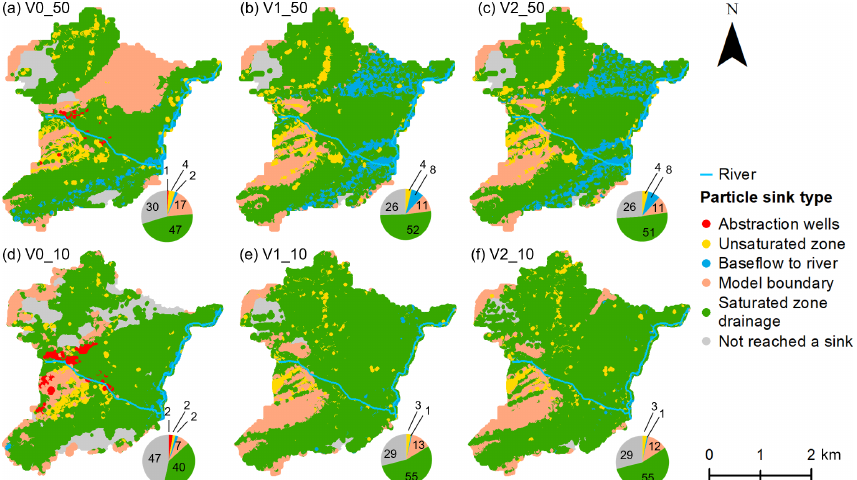
Figure 14. Start location of all released particles and their end-sink type. The sink type saturated-zone drainage includes leaking sewers. Pie diagrams show the percentage of particles ending up in the different